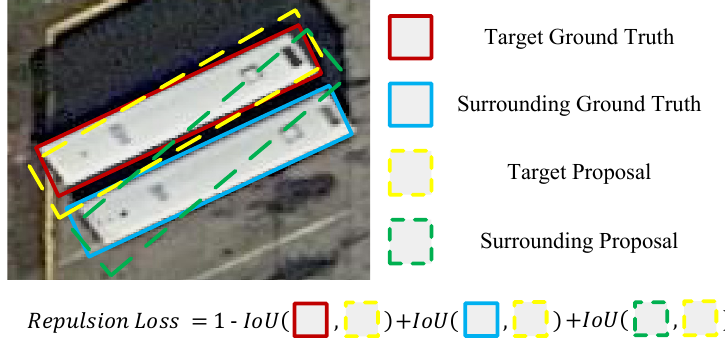
Figure 6. Visualization of repulsion constraint in the form of the loss